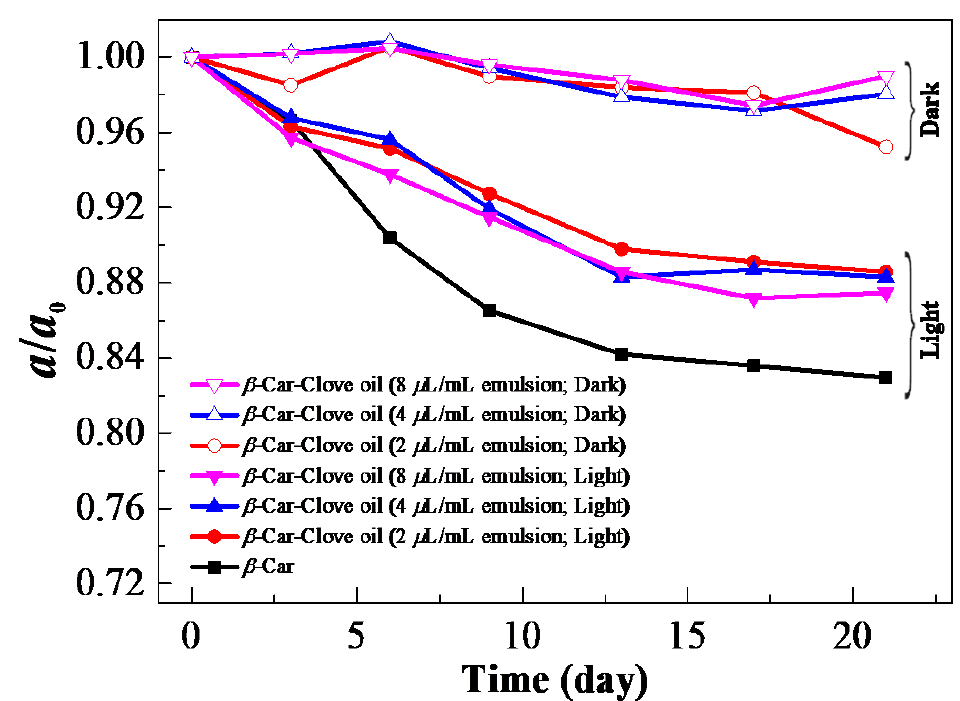
Figure 2. Red bleaching (relative redness a / a 0 ) of oil-in-water emulsion with β -Car with or without the addition of clove oil during storage in the dark or exposed to light of 22,000 Lx at 25 °C . Table 1. The redness parameter a of β -Car and β -Car-clove oil on light exposure compared to dark storage for different days. The redness parameter of 0 day is defined as a 0 .